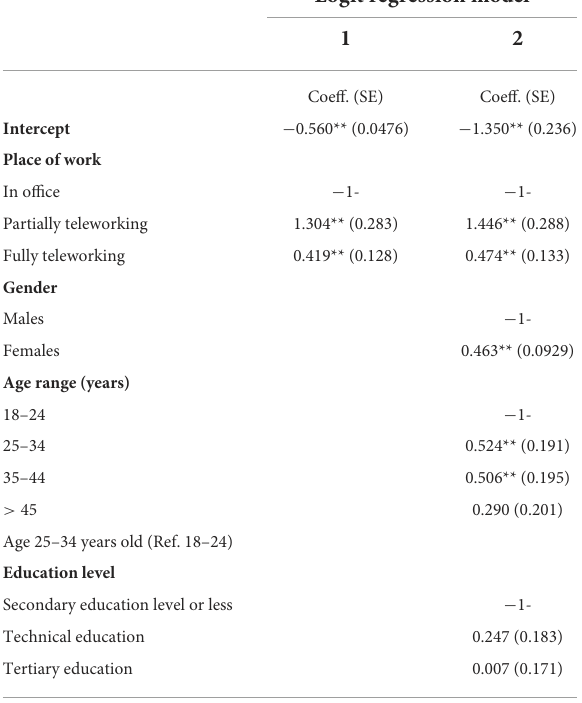
TABLE 5 Regression analysis of experiencing diet-related health issues by considering 2 sub-sets of variables: place of work (Logit model 1); place of work, age, and education level (Logit model